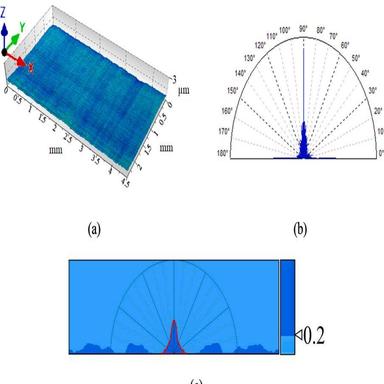
Surface texture of the polished surface: a) primary surface, b) morphological rose and c) polar graph of directional periodicity.